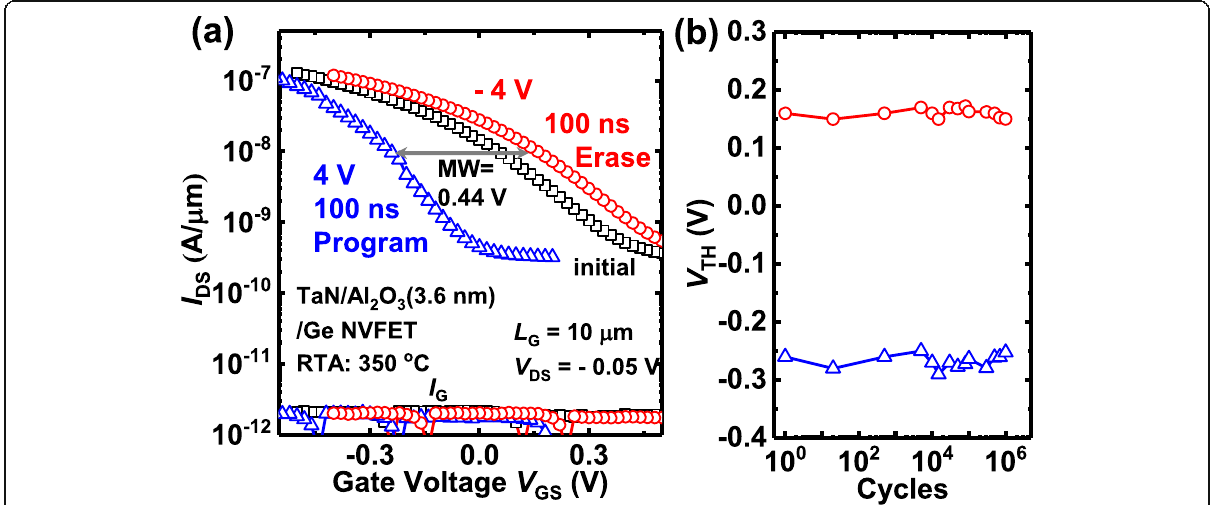
Fig. 5 a Measured I DS - V GS curves of a 3.6-nm-thick Al 2 O 3 NVFET for the initial and two polarization states. An MW of 0.44 V is obtained. b Endurance measurement demonstrates that no MW degradation is observed after 10 6 P/E